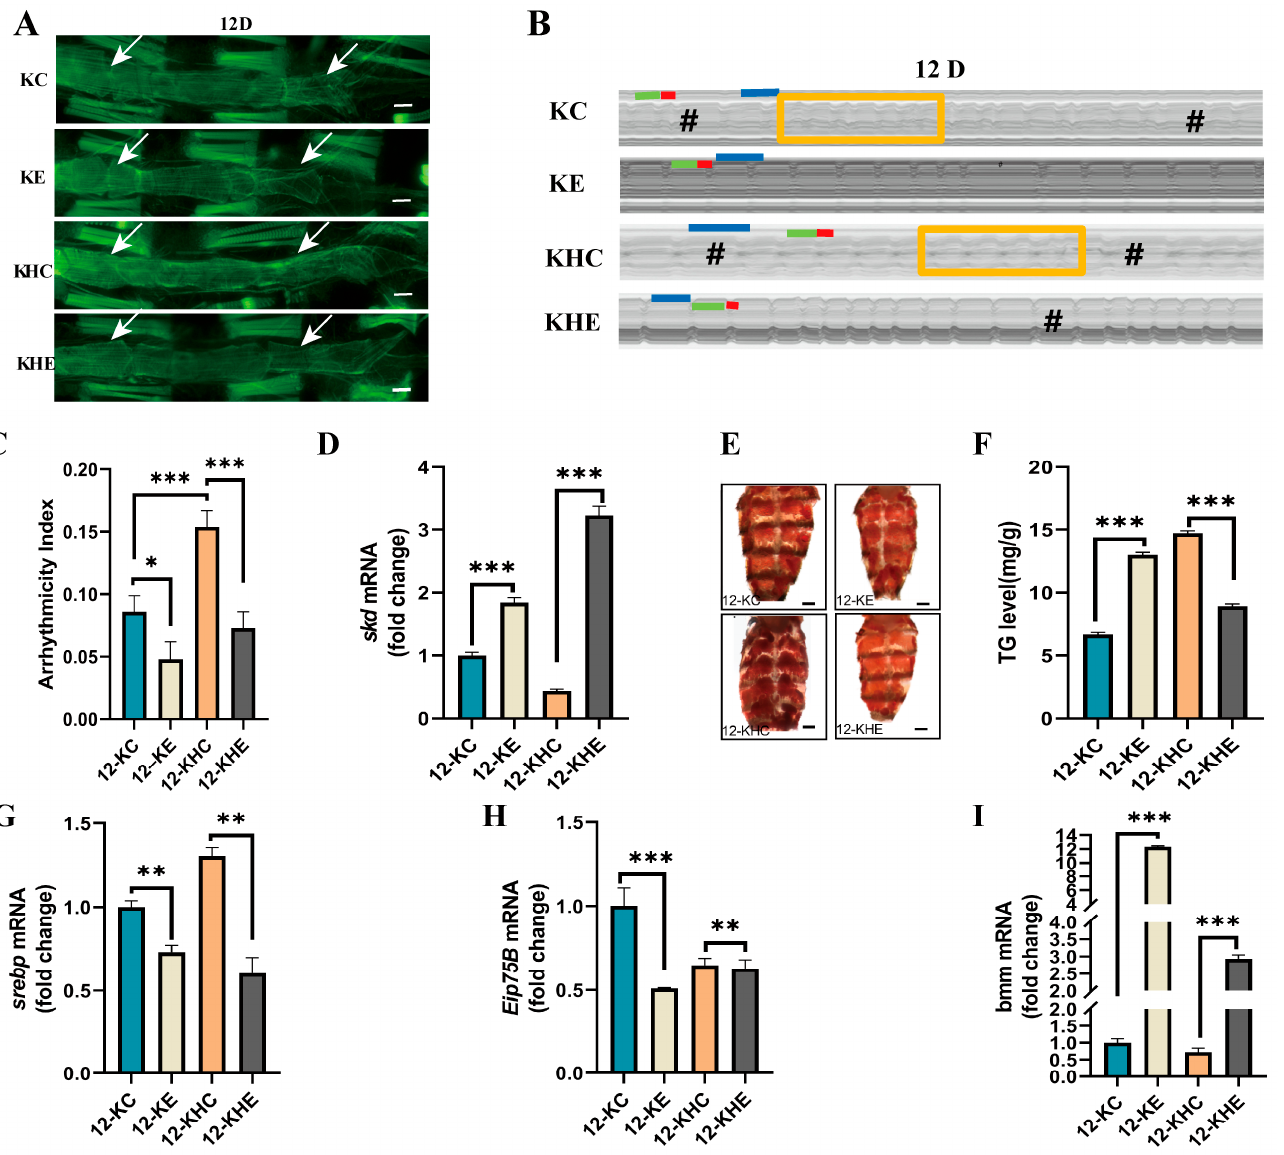
Figure 4. Effects of regular exercise on cardiac function and systemic obesity in Hand-Gal 4 > skd RNAi HFD Drosophila . ( A ) Cardiac F-actin staining in Drosophila . Note: scale bar = 100 µ m, The two white arrows point to the heart of the fruit fly. N = 5. ( B ) Effects of regular exercise on cardiac function in 12D NFD and HFD Hand-Gal 4 > skd RNAi Drosophila M-mode ECG. Note: Cardiac cycle—each group of M-mode ECGs was intercepted for 10 s, N = 25 ± 5. HP: horizontal blue line. DI: horizontal green line. SI: horizontal red line. Rectangle for fibrillation. # for cardiac arrest. ( C ) Effects of regular exercise on AI in cardiac function in 12D Hand-Gal 4 > skd RNAi NFD and HFD Drosophila . N = 25 ± 5. ( D ) Effects of regular exercise on cardiac skd mRNA expression levels in 12D NFD and HFD Hand-Gal 4 > skd RNAi Drosophila . ( E ) Abdominal ORO staining. scale bar = 250 μ m, N = 5. ( F ) Drosophila whole-body TG levels. ( G – I ) Cardiac tube srebp , bmm, and Eip75B mRNA expression levels after exercise intervention in 12D NFD and HFD Hand-Gal 4 > skd RNAi Drosophila . The independent-samples t test was used to assess the difference between the sedentary gr oup of Drosophila and the exercise group. * p < 0.05; ** p < 0.01; *** p < 0.001.